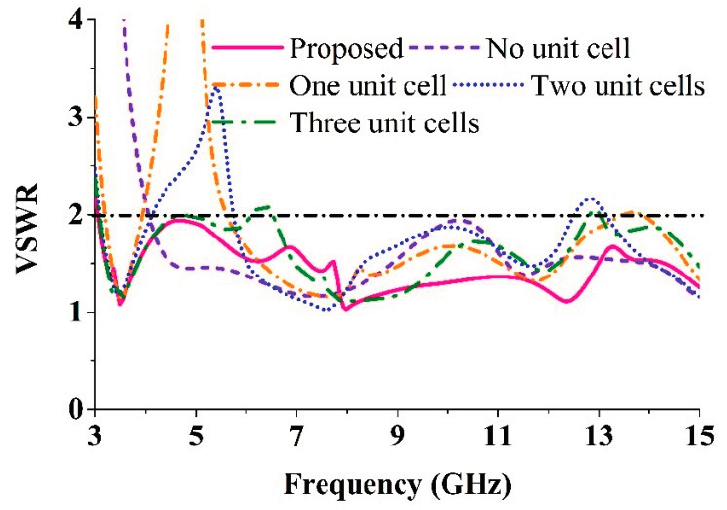
Figure 10. The effects of the unit cell of the patch on the